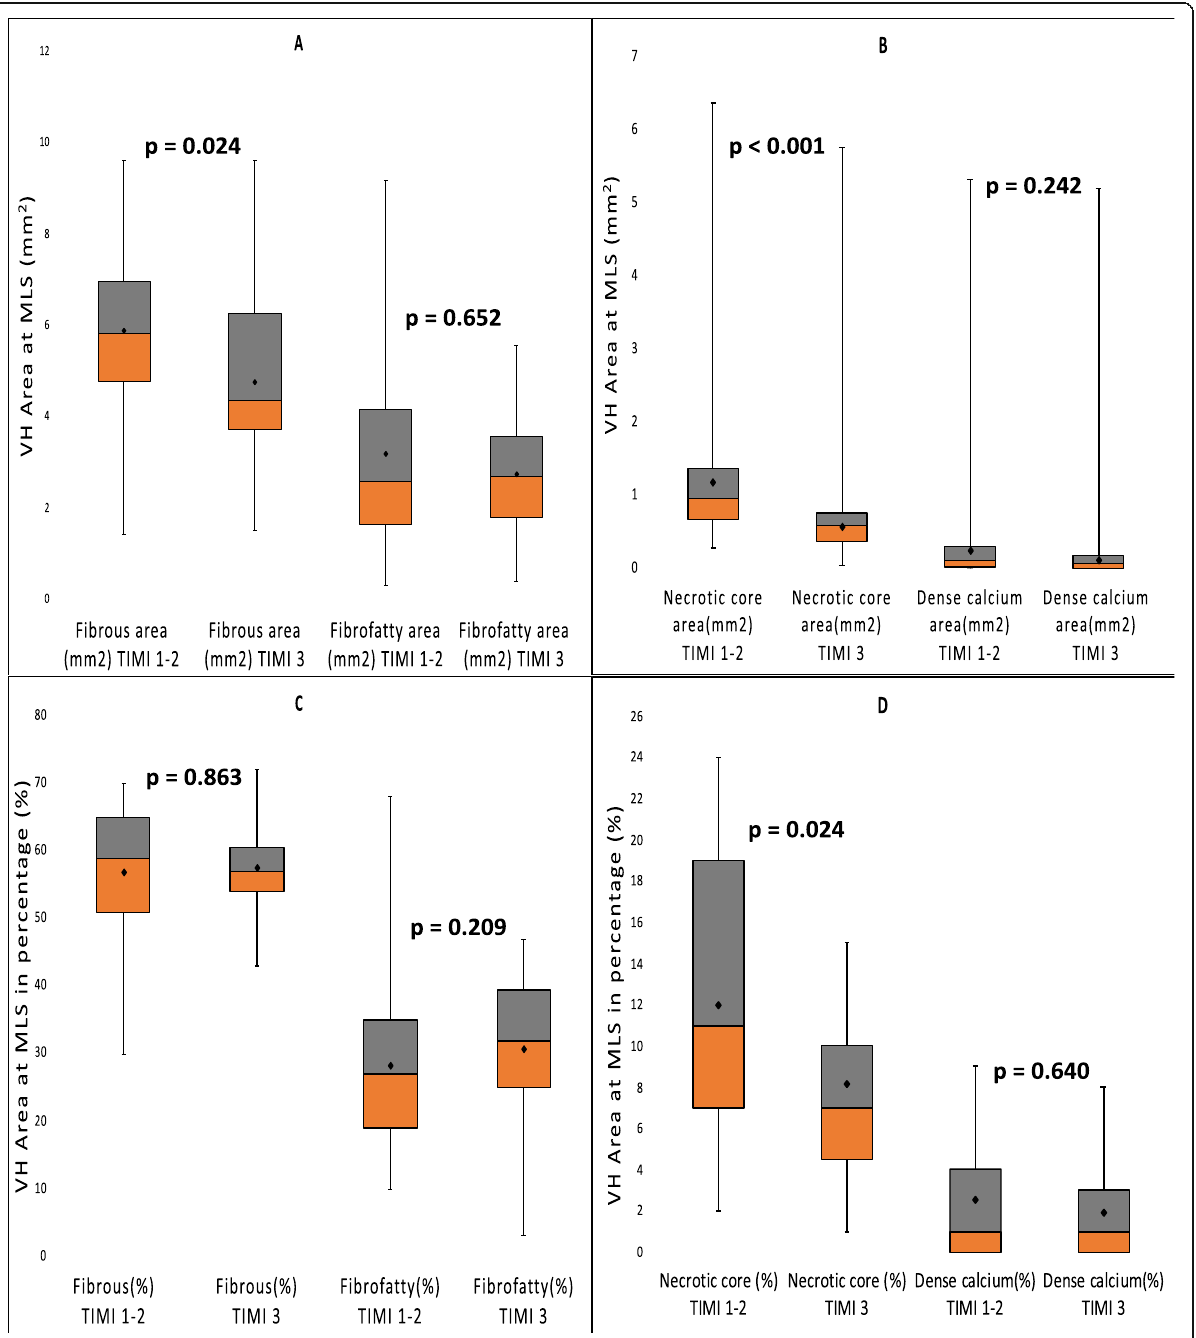
Fig. 1 The virtual histology plaque components in TIMI 1 – 2 and TIMI 3 groups at the minimum lumen area site (MLS). a , b The absolute plaque components and c , d the relative plaque components at the